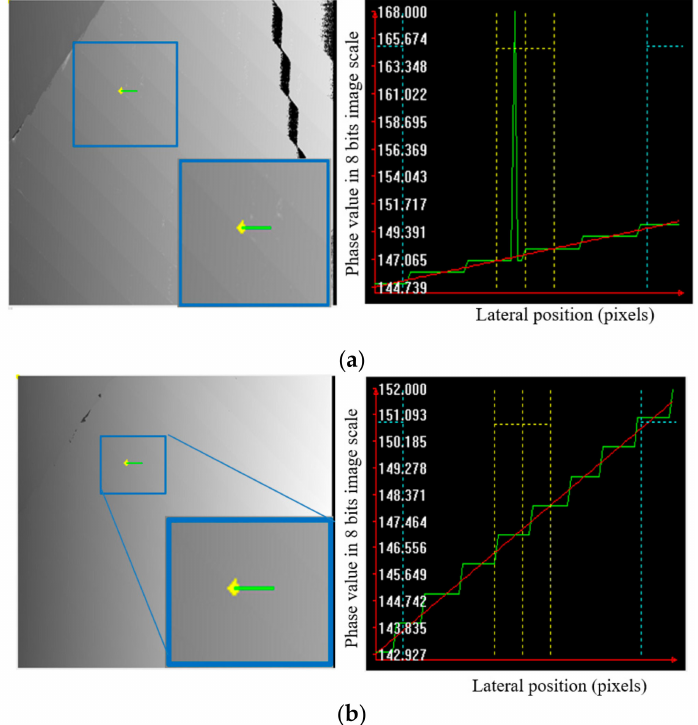
Figure 1. Unwrapped phase map and its cross-section measured by a fringe pitch of 12 pixels on a low-reflectivity step-height target using ( a ) temporal phase unwrapping (multifrequency) and ( b ) spatial phase unwrapping (Goldstein